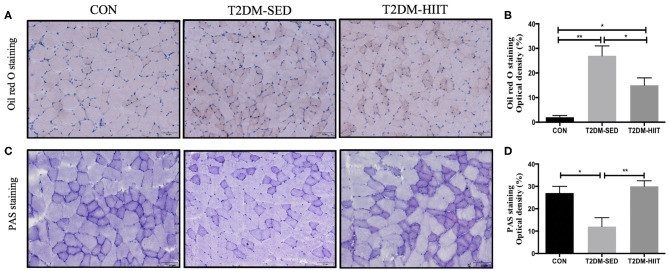
HIIT reduces lipid accumulation and increase glycogen abundance in skeletal muscle. (A) Oil red O staining of skeletal muscle (n = 3 for each group), (B) Quantification of lipid area, (C) PAS staining of skeletal muscle (n = 3 for each group), (D) Quantification of glycogen content. Scale bars, 50 μm. *p < 0.05, **p < 0.01.